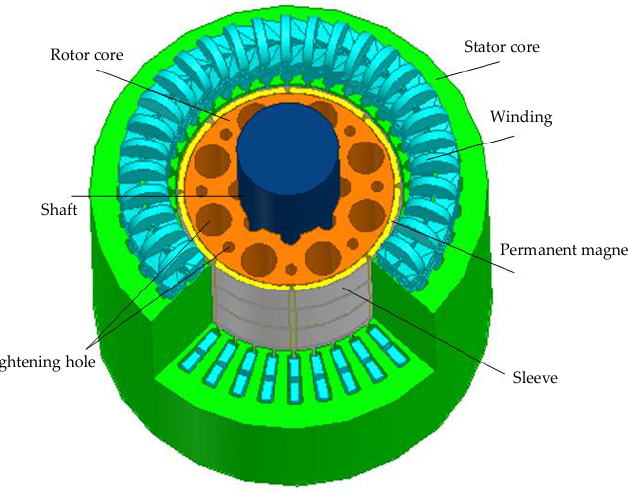
Figure 2. 3-D electromagnetic field calculation model.